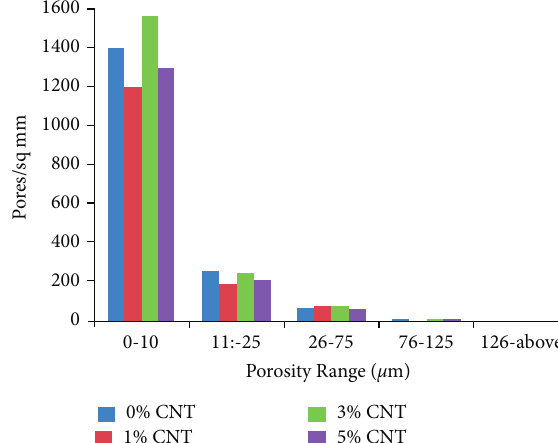
Figure 6: Porosity variation in alumina-titania coatings obtained with and without CNTs reinforcement.